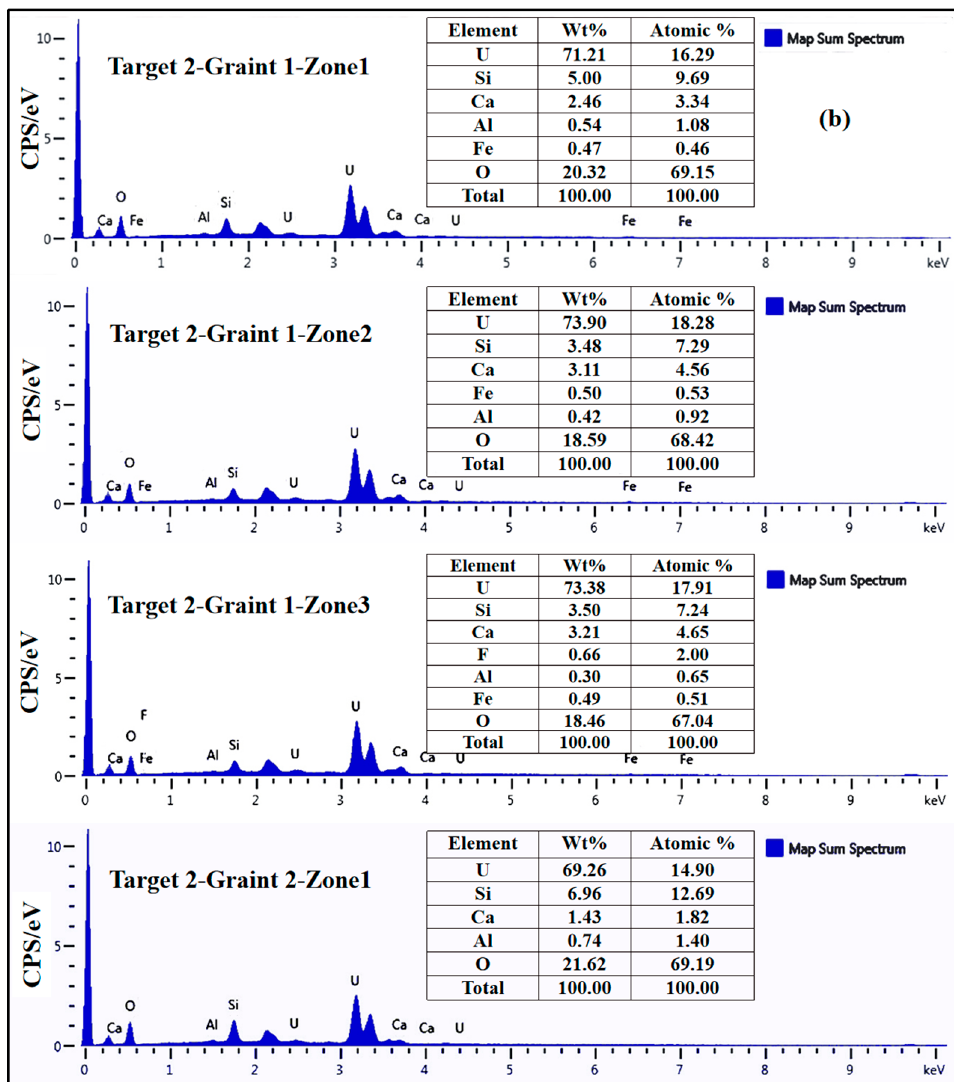
Figure 5. EDS mapping of the uraninite and related concentrations of elements from EDS. ( a ) The EDS mapping of Target 1. ( b ) The EDS mapping of Target 2. The peak value was the Au, which was coated to create a conductive surface.